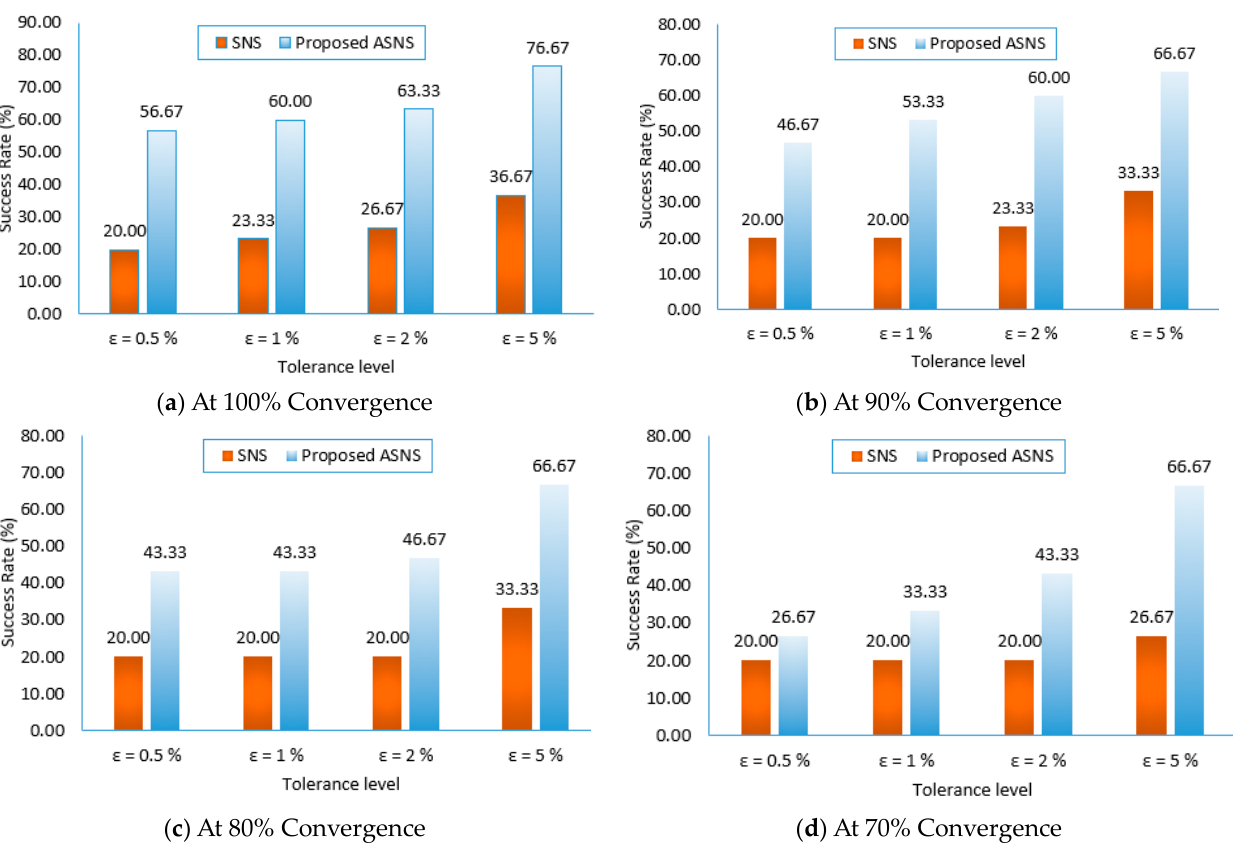
Figure 17. Success rates of SNS and ASNS for Case 1 for the IEEE 30-bus system. Table 16. Success rates for different values of the ASNS parameters used for minimizing the losses (Case 1) for the IEEE 30-bus system.